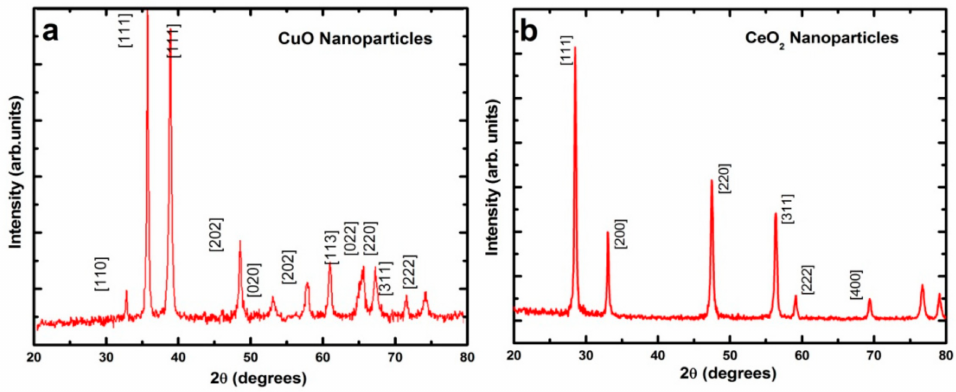
Figure 1. X-ray di ff raction pattern of ( a ) CuO NPs and ( b ) CeO 2